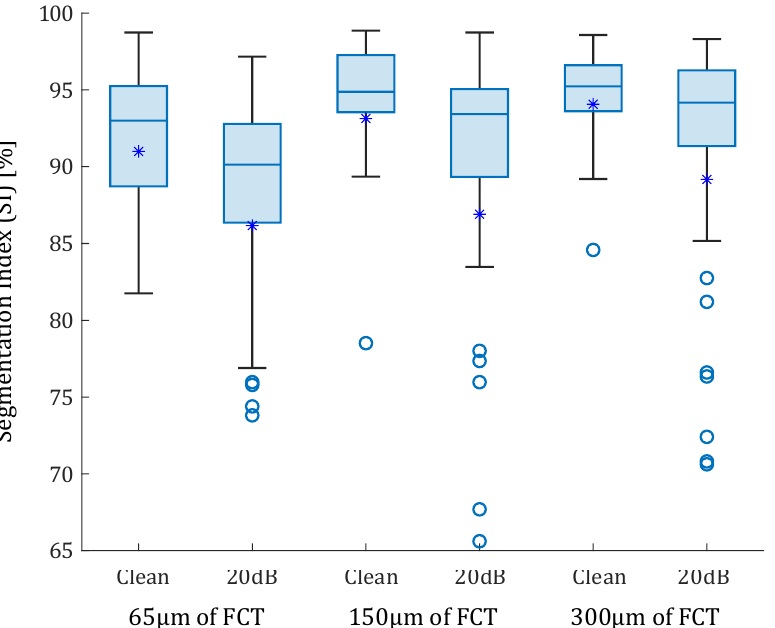
Figure 6. Box-plots of the SI values of the idealized geometries. From left to right: 65, 150, and 300 µ m of fibrous cap thickness. Each geometry was analyzed with clean strains and with 20 dB of SNR. The median values were represented with a horizontal line. The median values were 93% and 90.14% for the idealized geometry with 65 µ m FCT with and without noise; 94.88% and 93.42% for geometry of 150 µ m FCT; and 95.23% and 94.17% for 300 µ m. Mean values are represented with asterisks. Outliers are represented with circles. Some outliers were below 65% but are not